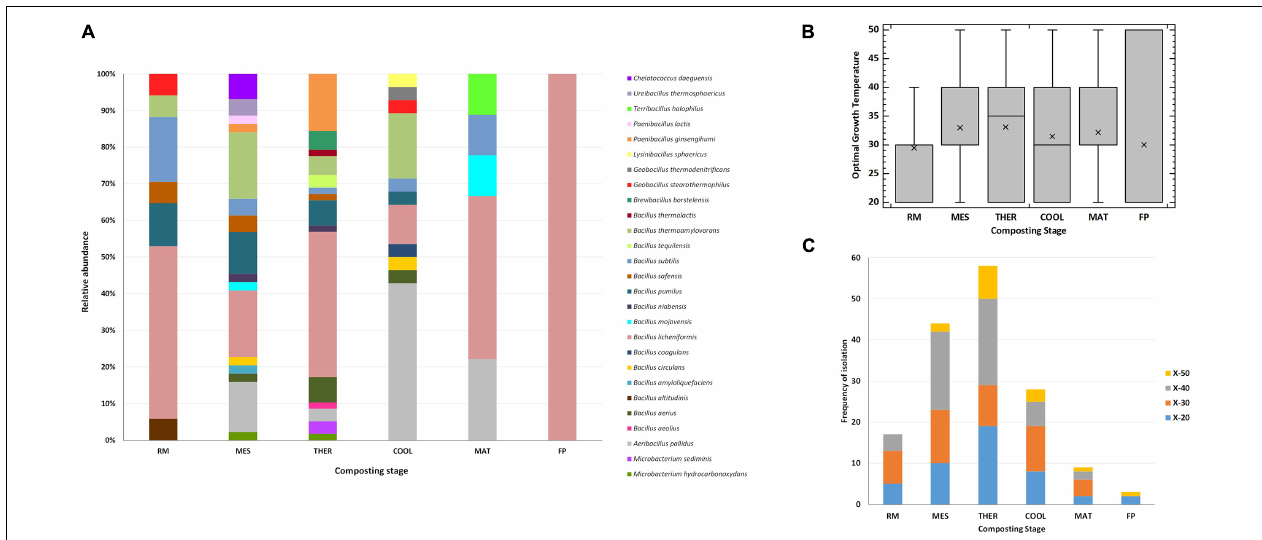
FIGURE 3 | Thermophilic xylanolytic bacterial strains at the different stages of composting. (A) Relative abundance of the species; (B) Box-and-whisker plot with the range of optimal growth temperature for the different strains, mean values (x), median (I) and outliers ( (cid:3) ) are represented; (C) frequency of isolation of the bacterial phenotypes: xylanolytic strains with optimal growth at 20 ◦ C (X-20), 30 ◦ C (X-30), 40 ◦ C (X-40) and 50 ◦ C (X-50). Composting stage: RM, raw material; MES, mesophilic; THER, thermophilic; COOL, cooling; FP, final composting